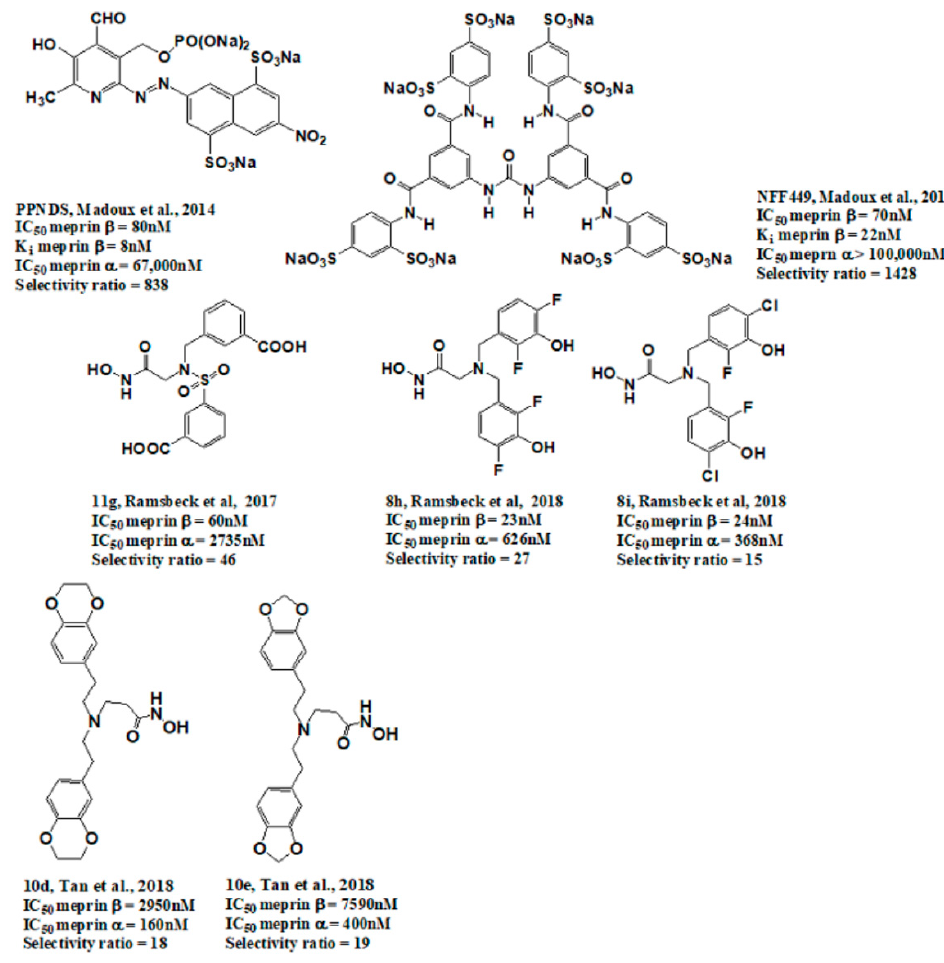
Figure 1. Synthetic selective meprin inhibitors described to date.